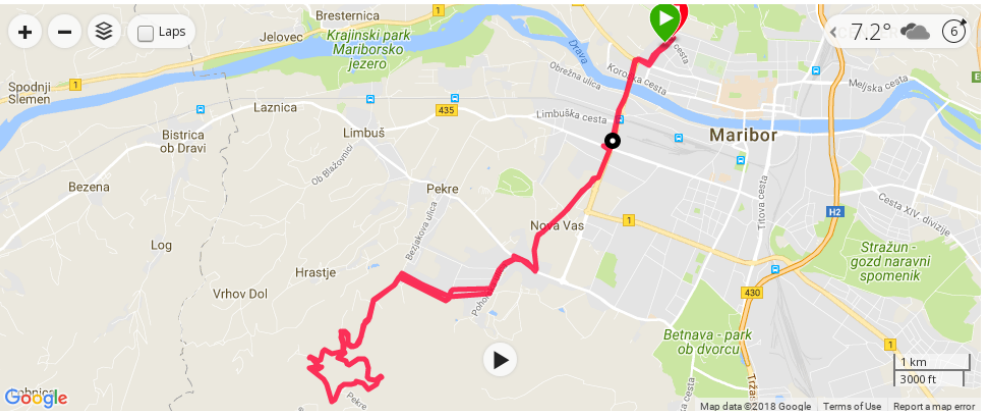
Figure 2. Trajectory plot (full map) of a short mountain bike ride that was completed in Maribor (Slovenia). The data were recorded by a Garmin Vivo Active HR watch that allows one to measure one’s heart rate directly on the